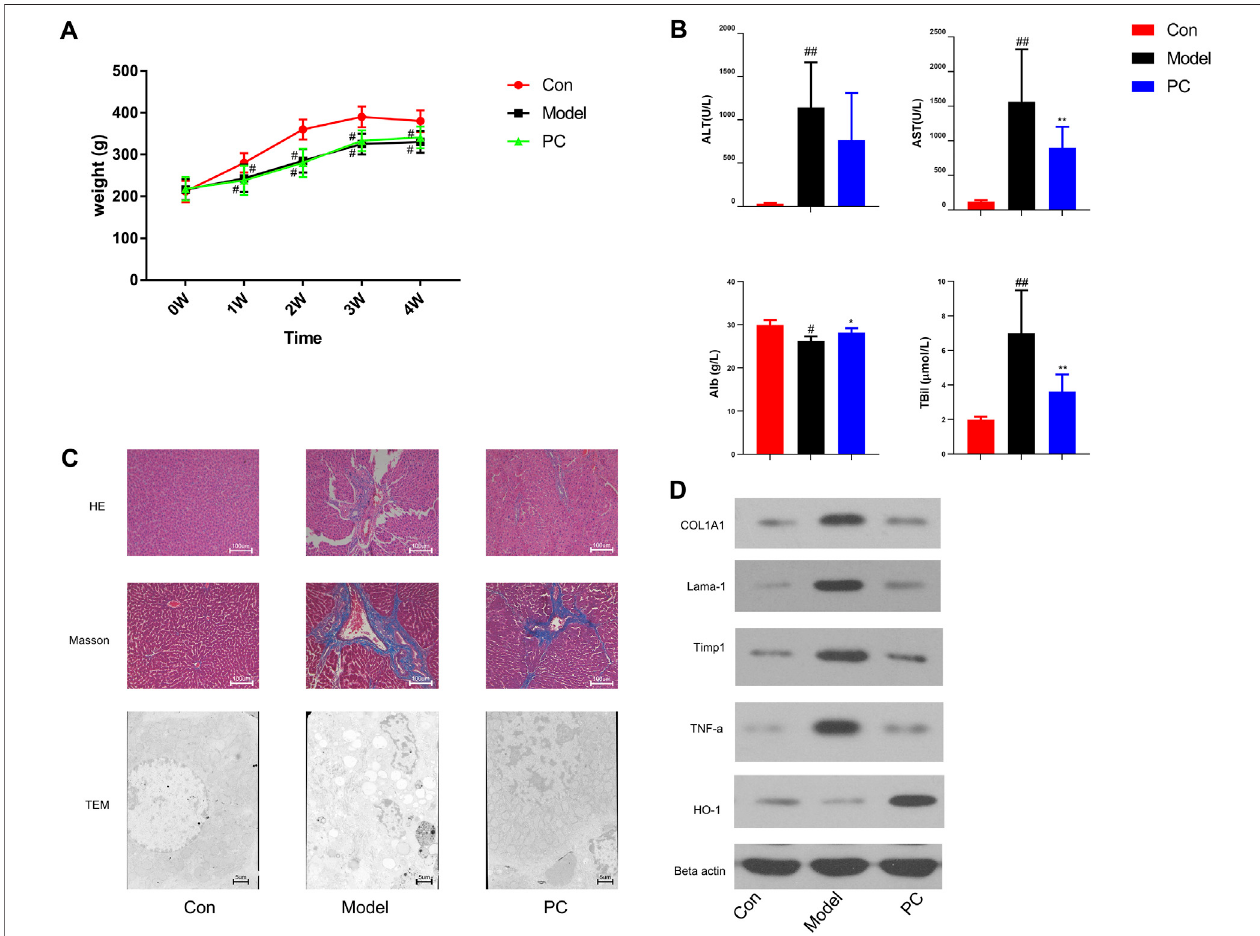
FIGURE7| Evaluationofthetherapeuticeffectof P.chinense inCCl 4 -inducedliver fi brosisrats (A) Bodyweightchange(mean±SD). (B) LevelsofserumATL,AST, Alb, and TBil in different groups. (C) HE staining (×100), Masson staining (×100), and TEM scanning (×500) of liver tissues in each group. (D) Expressions of COL1A, Lama-1, Timp1, TNF- α , and HO-1 in rat liver tissues were detected by Western blot. The data are presented as the means ± SDs of the results from three independent experiments and were analyzed by ANOVA. # p < 0.05, ## p < 0.01 compared to the control group, and * p < 0.05, ** p < 0.01 compared to the model group. PC, P. chinense